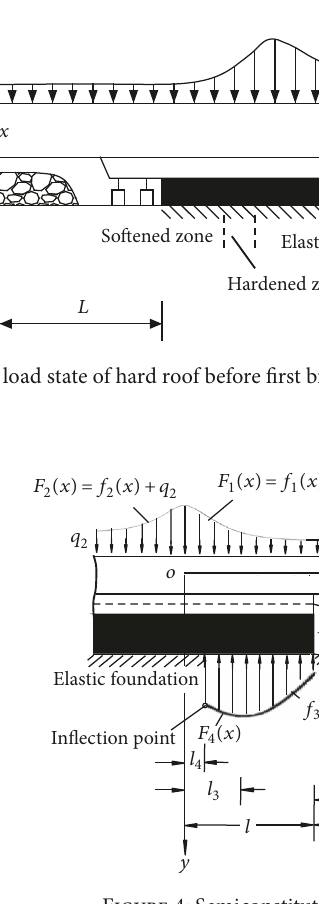
Figure 4: Semiconstitution model of hard